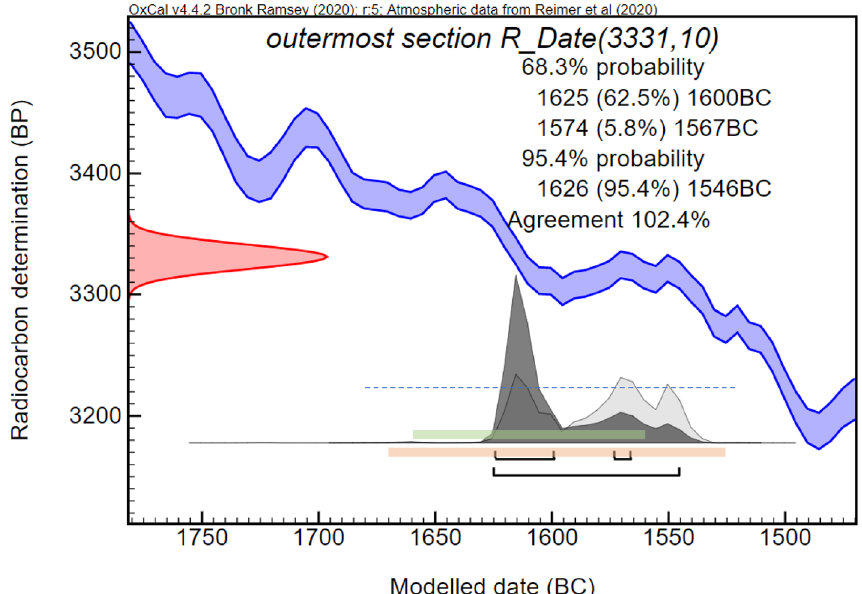
Figure 6. Probability distribution (dark gray) of modelled date range for the olive branch radiocarbon measurment 13 (red) calibrated against IntCal20 14 . In the 1σ range, not all dates have an equal probability, as there are two peaks (1625–1600 with 62.5% out of the 68.2%; and 1574–1567 with only 5.8%). The 2σ range adds only one year to the beginning of the probable date range compared to 1σ, however, it adds another 21 years to the end of the range, which has a much lower probability than the pre-1600 range. Presenting the date range without specific probability information might be misleading. We therefore present date ranges which include probabilities of all included date